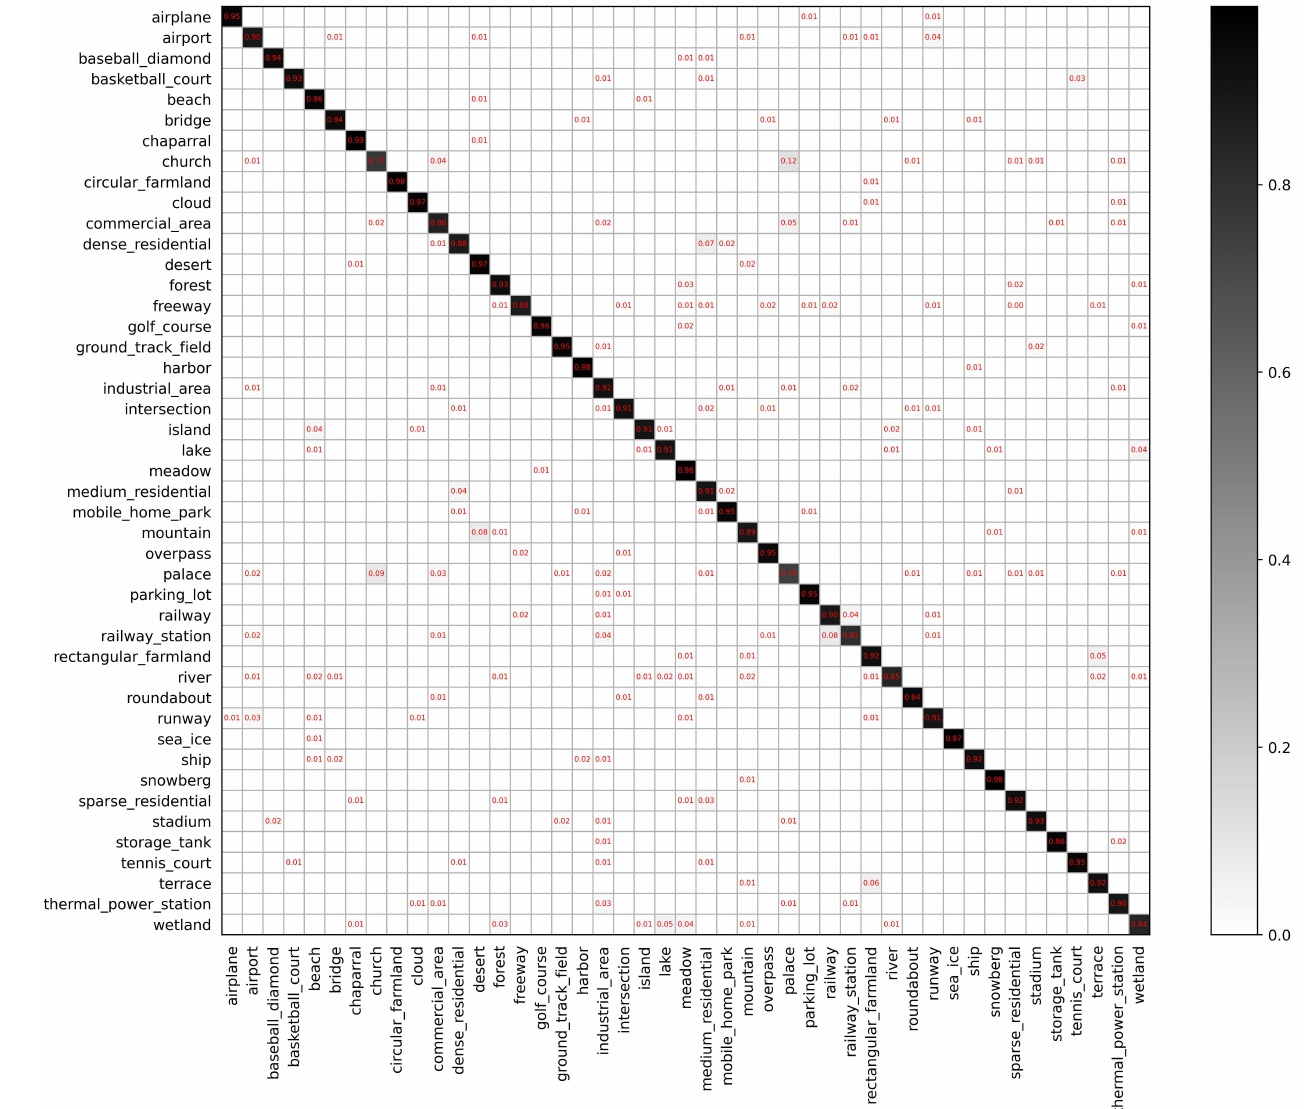
Figure 13. Confusion matrix of the proposed method on the NWPU-RESISC45 dataset with a training ratio of